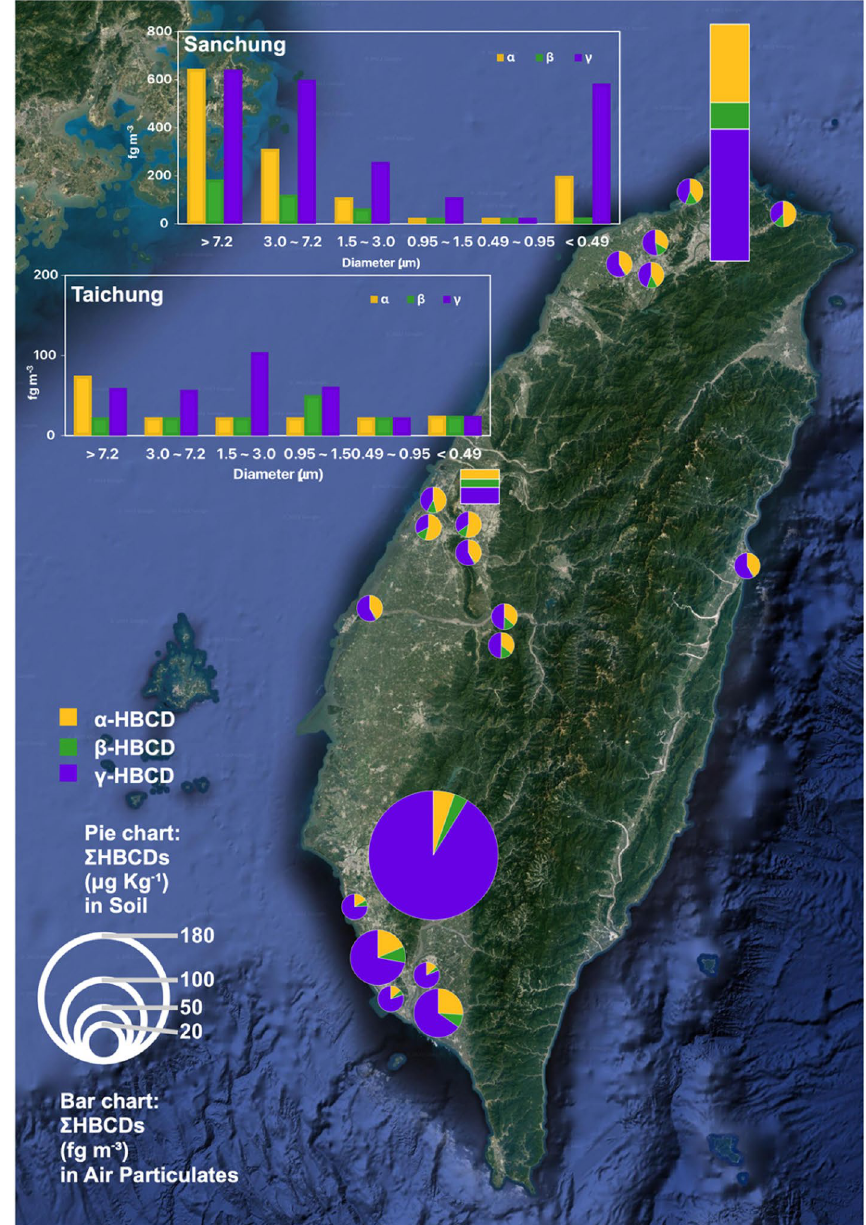
Fig. 2 The average concentrations of HBCDs in soil (pie) and the average concentrations of HBCDs